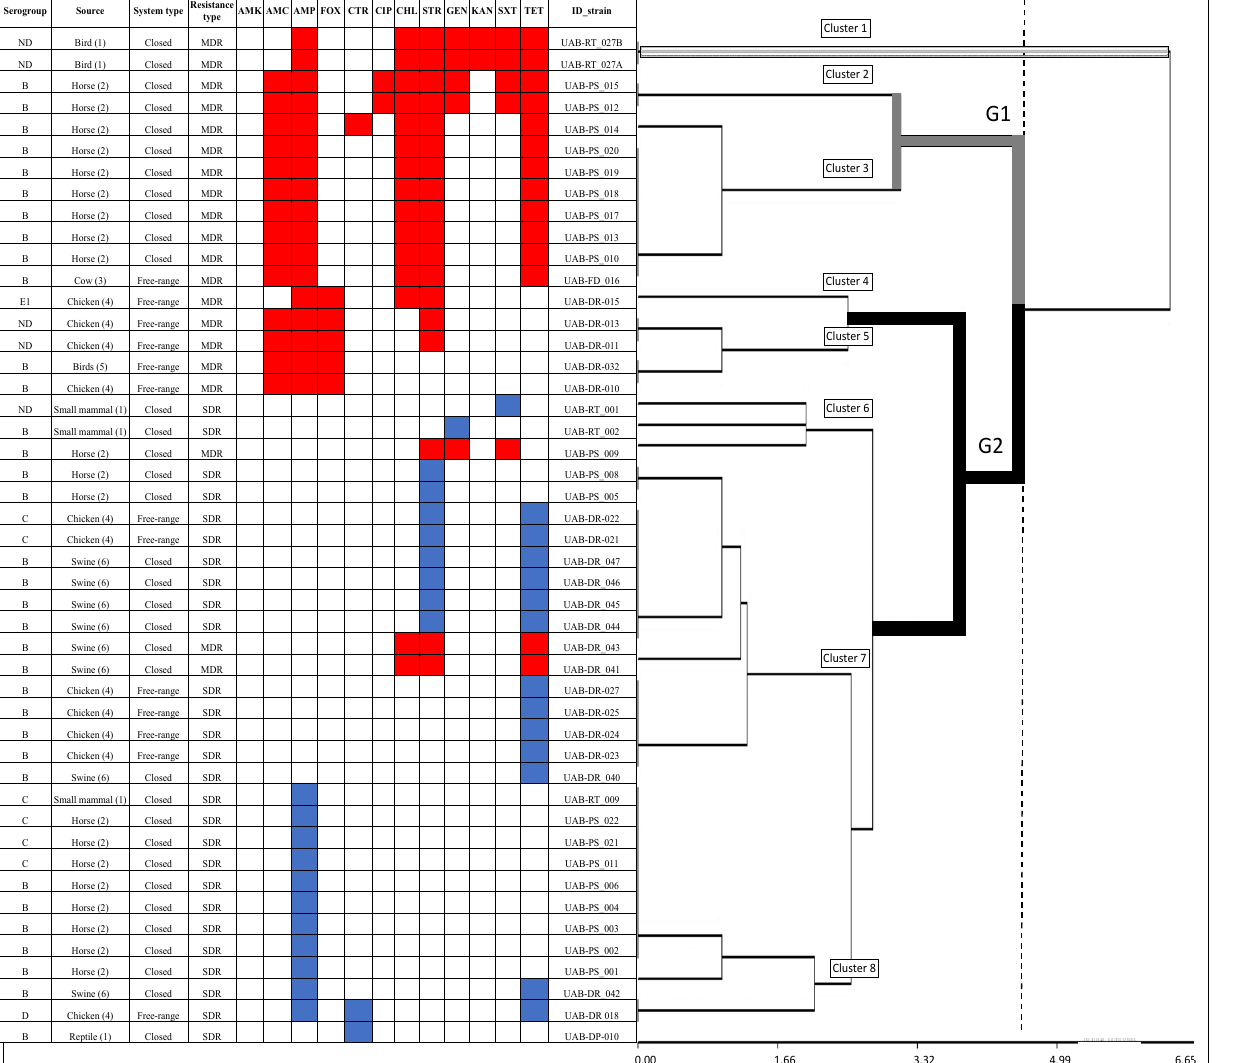
Figure 2. Dendrogram showing clustering of antimicrobial resistance profiles identified in Salmonella strains. Dendrogram was obtained from a conglomerate analysis (Infostat version 2017) without restricting the number of clusters. The animal sources where samples were collected corresponded to: (1) wildlife in rehabilitation centers; (2) equine veterinary hospital; (3) free-range dairy farms; (4) chickens backyard farms; (5) wetland birds; (6) industrial swine. Two principal groups were obtained: G1 included MDR strain clusters 2–3, G2 included clusters 4–8 and cluster 1 was set apart with a broad resistance profile. MDR in blue and SDR in red indicate resistance, while white indicates susceptibility. Euclidean distance fluctuation between 0.0–6.5 was marked vertically with a flashing line. Abbreviations: AMC, amoxicillin-clavulanic acid; AMP, ampicillin; FOX, cefoxitin; CTR, ceftriaxone; CIP, ciprofloxacin; CHL, chloramphenicol; STR, streptomycin; GEN, gentamycin; KAN, kanamycin; SXT, trimethoprim/sulfamethoxazole; TE, tetracycline.